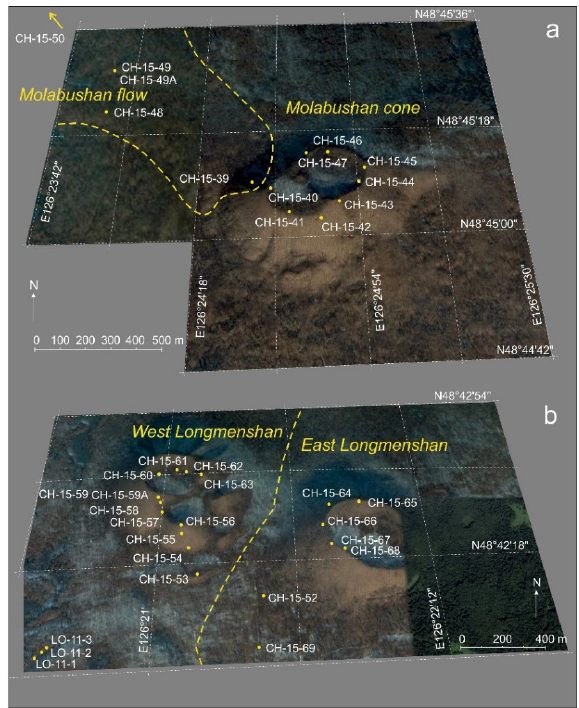
Figure 4. Location of sampling sites in the Molabushan ( a ) and Longmenshan ( b ) volcanoes.